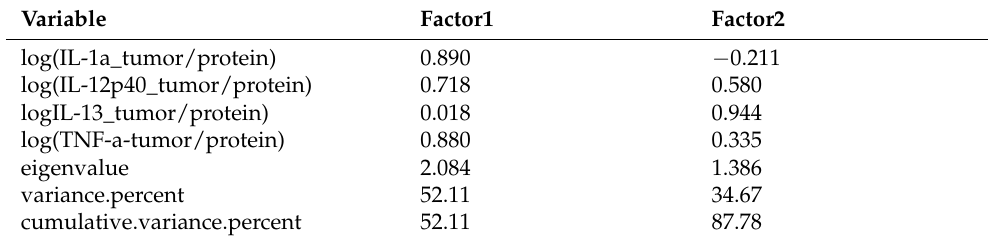
Figure 7. Correlation between HHLA2 tumor concentration and trophic factor1 from principal com- ponent analysis containing HGF, M-CSF, b-NGF, SCGF-b, IL-7, FGFbasic, G-CSF, PDGF-bb, VEGF, GM-CSF.